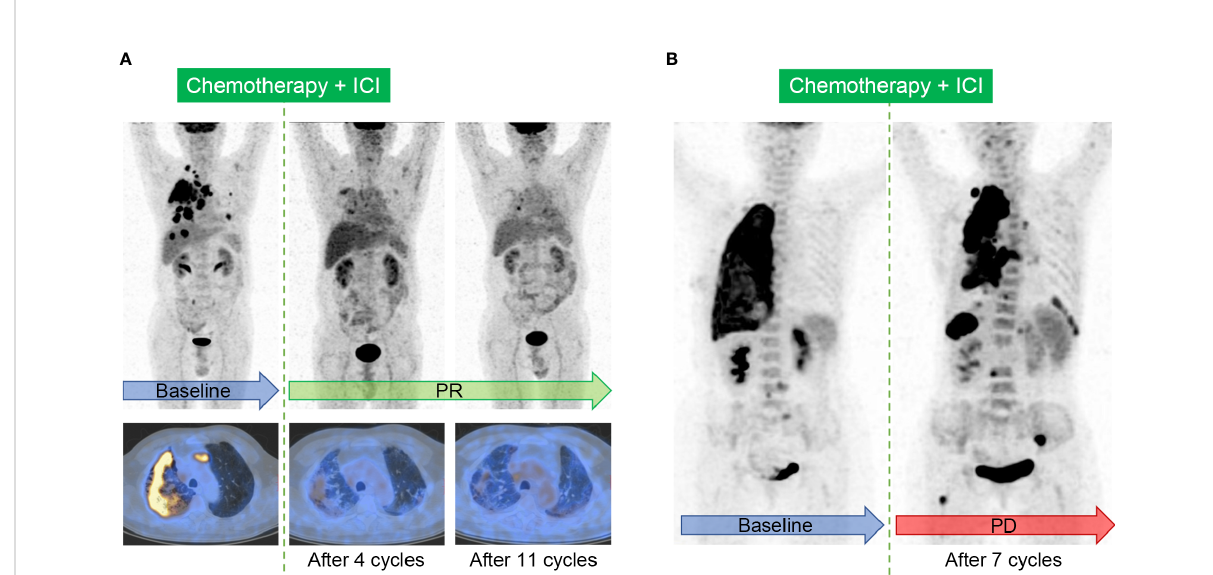
FIGURE 4 Typical cases evaluated by Response Evaluation Criteria in Solid Tumors (RECIST) 1.1 in patients with ICI treatment. (A) , Immunotherapy response in a 64-year-old male patient with right lung adenocarcinoma. The baseline image shows intensive FDG uptake in the primary tumor, accompanied with multifocal intrapulmonary metastasis, lymphadenopathy, and the involvement of pleura. Follow-up images after 4 cycles and sequential 11 cycles of the combination of chemotherapy and ICI show partial response (PR). (B) , Immunotherapy response in a 60-year-old female patient with right lung adenocarcinoma. Image after 7 cycles of the combination of chemotherapy and ICI shows the enlargement and increased metabolism in the primary tumor, and the onset of multiple new lesions in the lung, pleura, lymph nodes, liver, and bone, indicating progressive disease (PD).